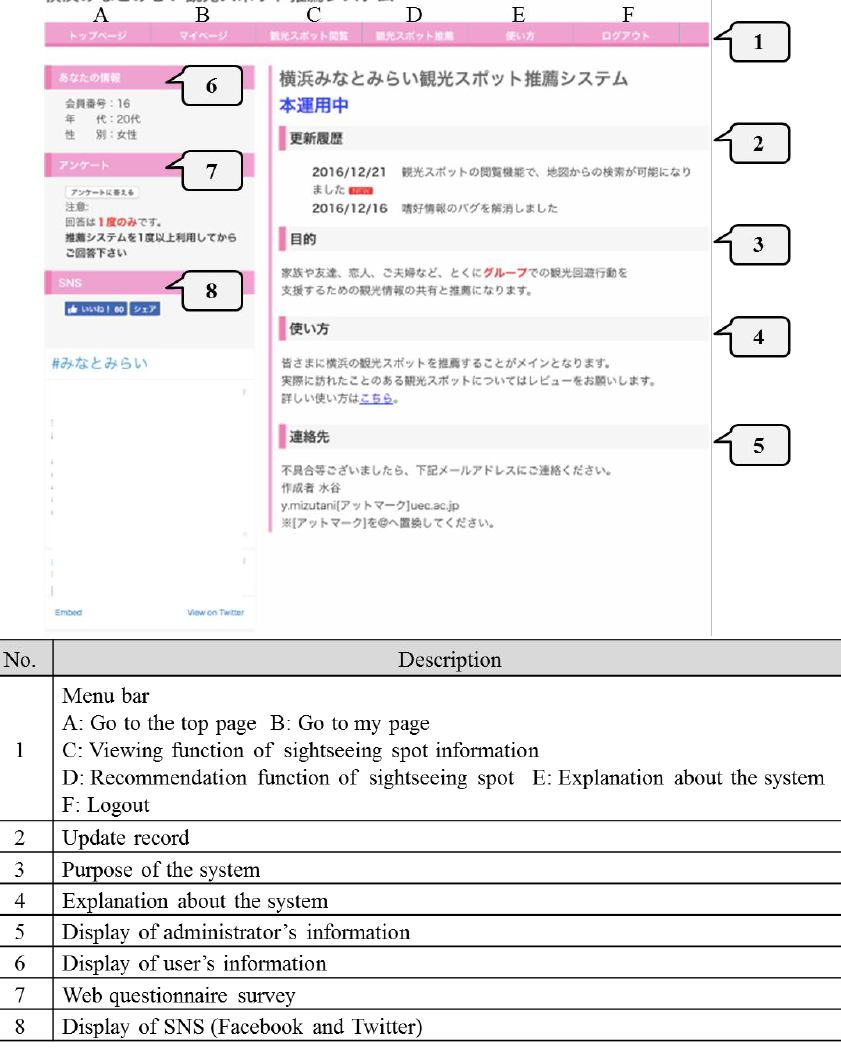
Figure 8. User’s PC screen and explanation of each function.